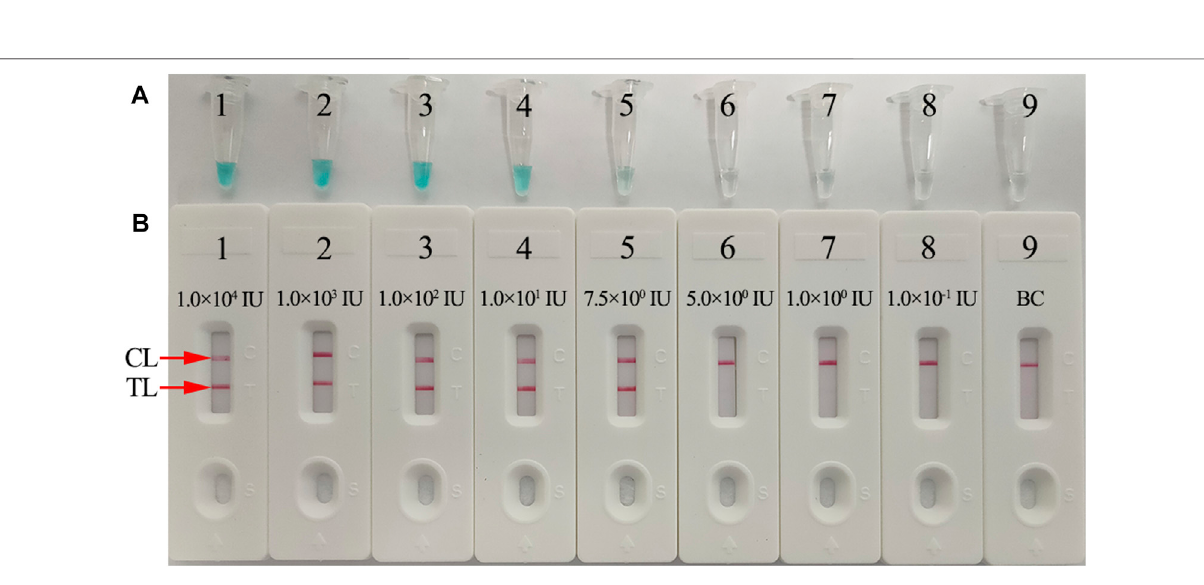
Frontiers in Bioengineering and Biotechnology |